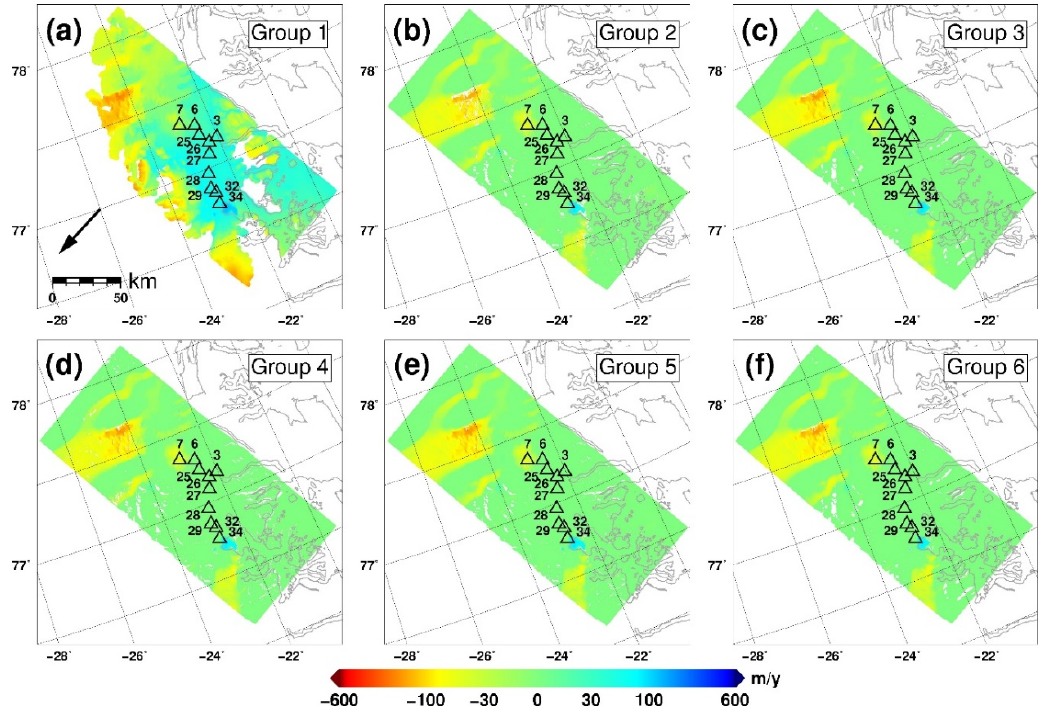
Figure 3. Task 1 LoS velocity maps provided by groups 1 to 6 ( a – f ). Positive values correspond to motion towards the radar along the LoS vector (from ground to satellite), the ground projection of which at scene center is shown by the arrow in ( a ). Triangles represent the GPS stations used for validation.